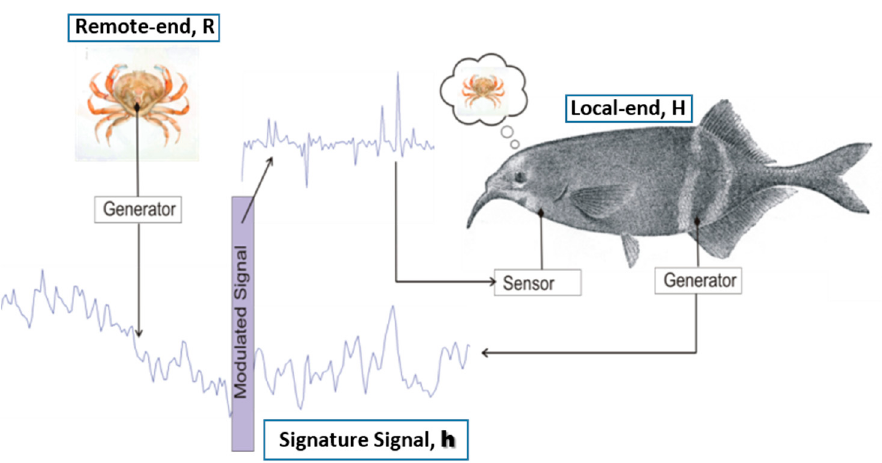
Figure 2. Bioinspired electroceptive compressive sensing (BeCoS) sensing approach.